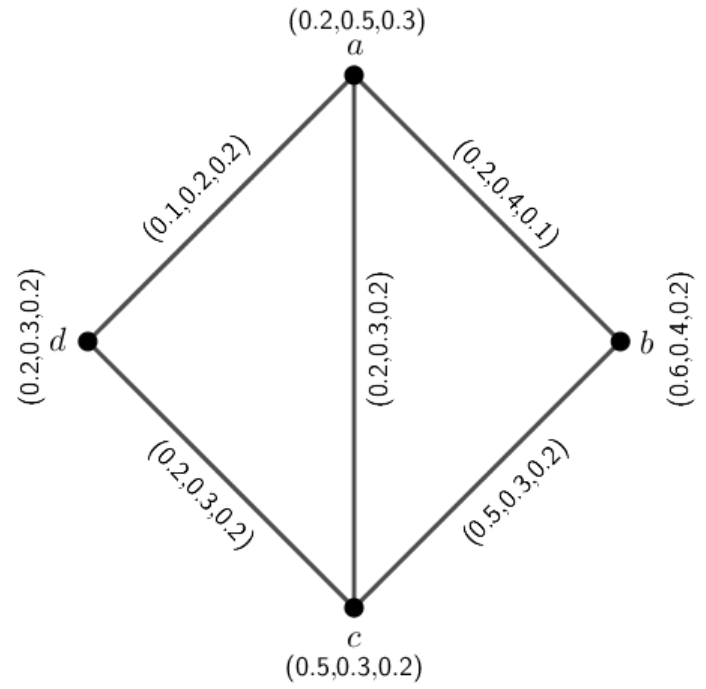
Figure 3. Edge integrity of 3PFG Γ